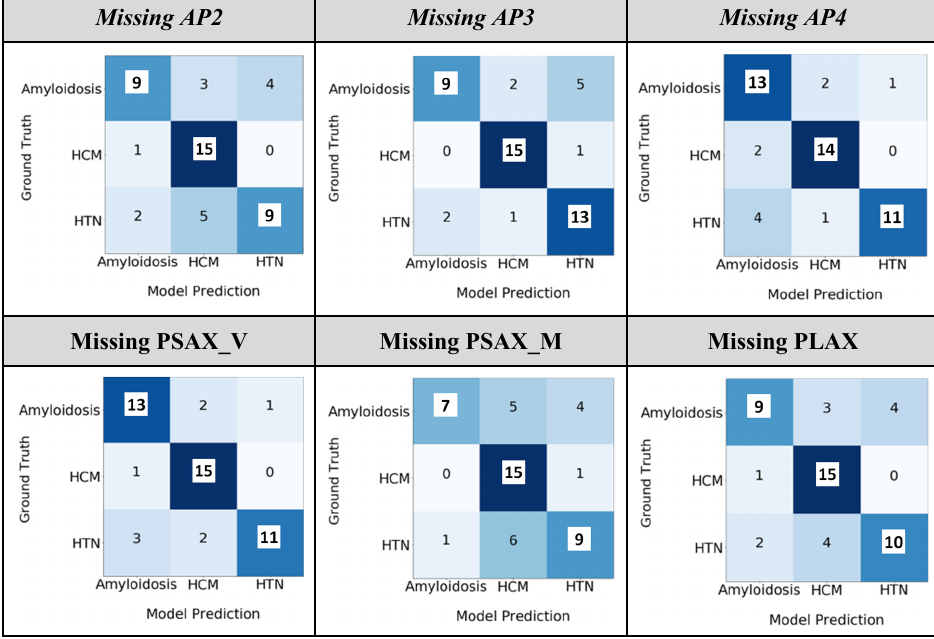
Figure 5. Ablation study of the fusion model at the study level by dropping one view. The ‘HTN/other’ category is referred to as ‘HTN’. In chamber-level ablation, obfuscating quadrant 1 (LV), which represents the left ventricle (LV) of the heart has the most significant drop in the AP4 model performance (CA—0.57, HCM—0.78, and HTN/other—0.65), which reflects that LV was involved most in all these diseases. Interestingly, removing the portion of any single chamber from the input AP4 image led to a significant drop in performance in identifying CA cases (Figure 6) which reflected the nature of CA as a systemic disease involving all four chambers of the heart.